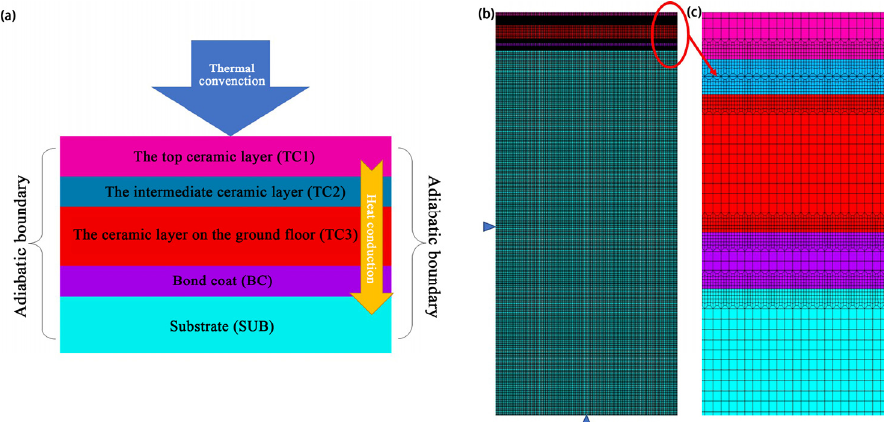
Figure 2. Numerical models: ( a ) simple physical model; ( b ) finite element model and mesh and ( c ) local magnification of model 2b.